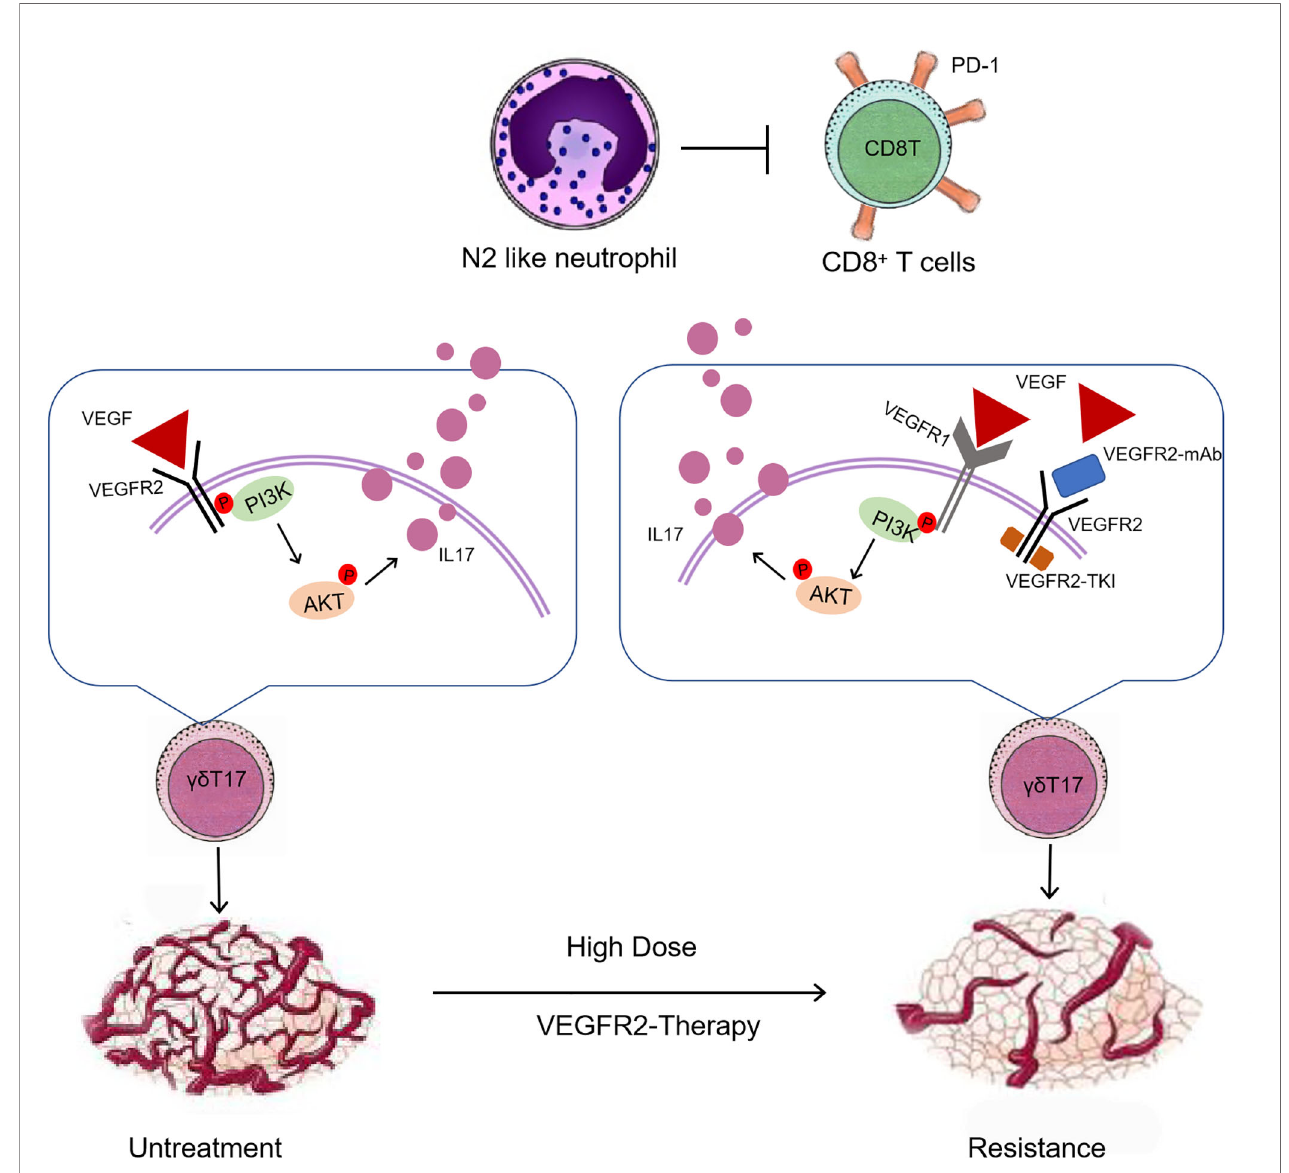
FIGURE 8 | An overview schematic demonstrating that high-dose anti-VEGFR2 treatment modi fi es the tumor immunosuppression microenvironment via “ gd T cell- IL17A-neutrophil ”